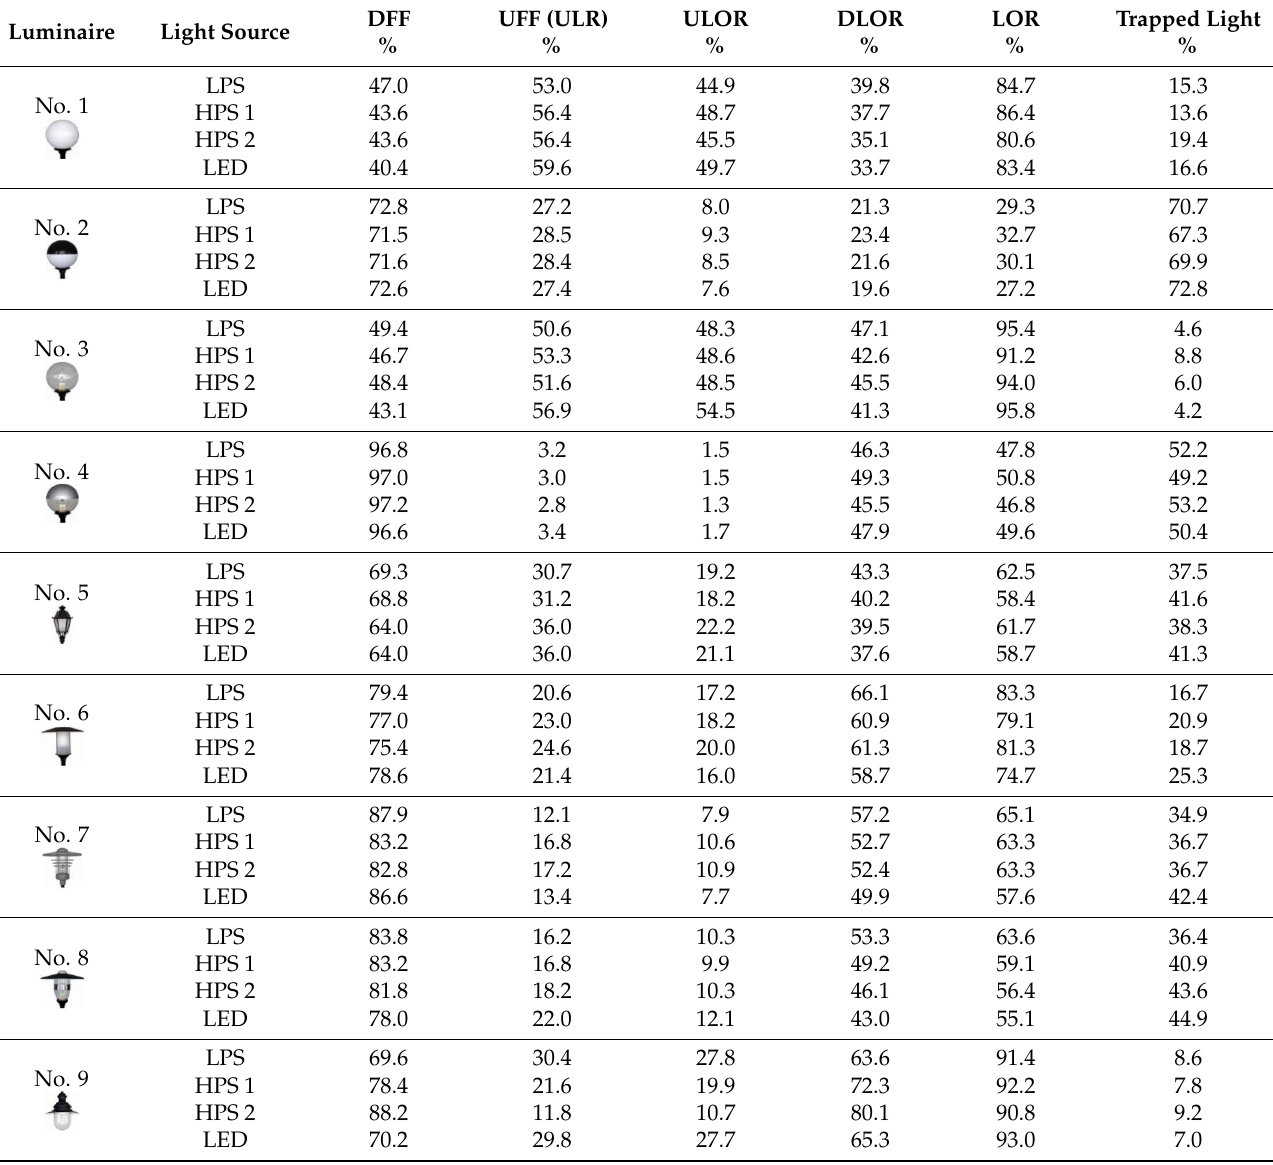
Table 5. Parameters of the luminaires considered to cooperate with the sodium lamp and LED calculated on the basis of the measured photometric solids. Luminaire Light